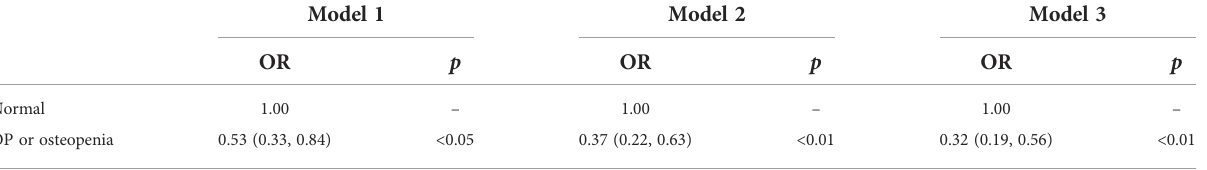
TABLE 3 Association between taking antiplatelet agents and OP or osteopenia.